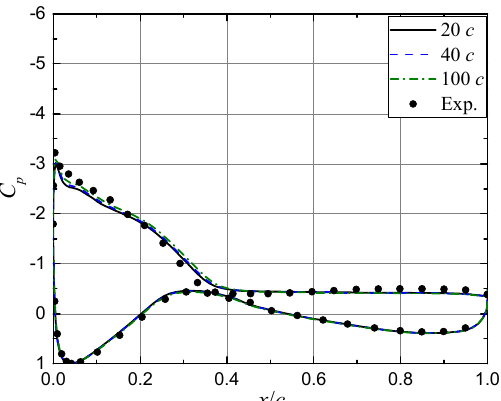
α = 15 ° without VGs.